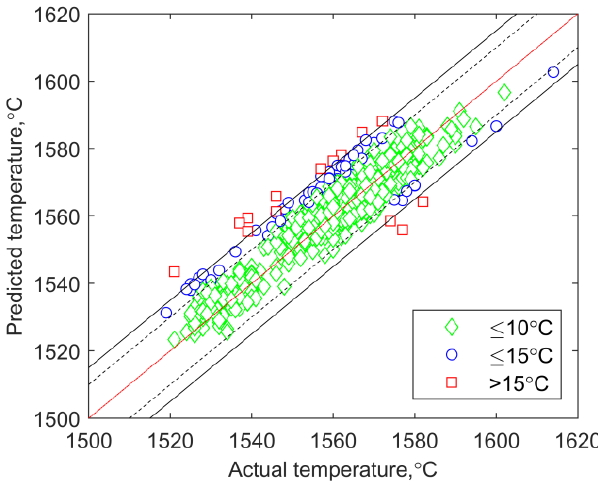
Figure 6. Residual graph of end temperature between actual and predicted